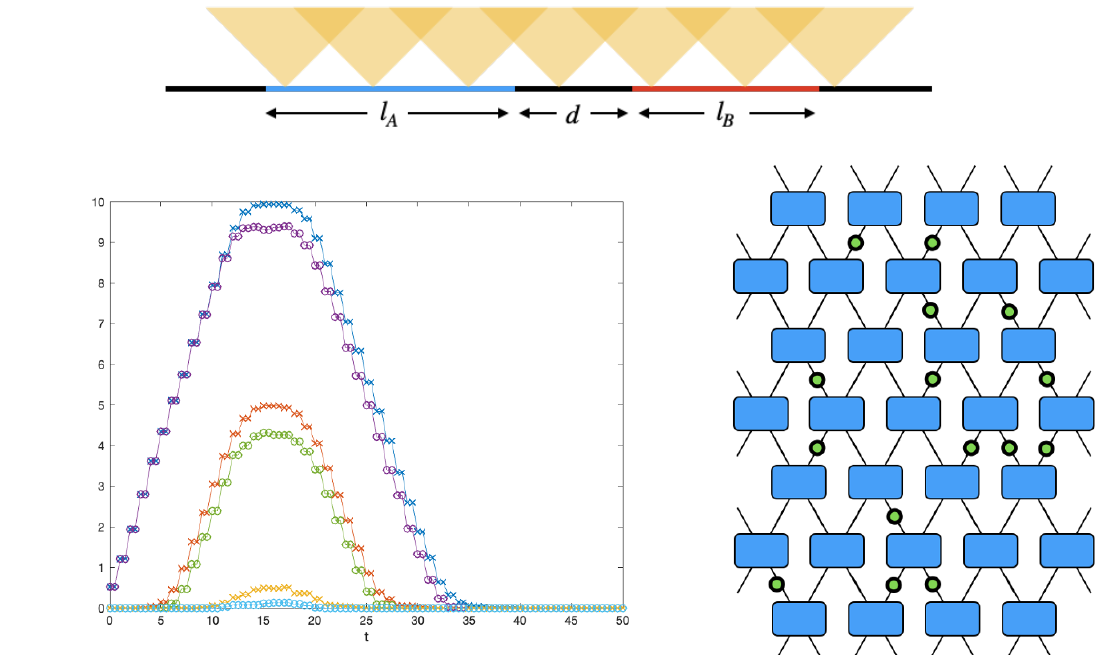
Figure 16 . The mutual information ( (cid:2) ’s) and EPR pairs ( (cid:14) ’s) between region A (blue) and B (red) after a global quantum quench. We start in the product state of all spin up and take l A = 30, l B = 20, d = f 0 ; 10 ; 20 g . On the right, we show a cartoon of the random Cli(cid:11)ord circuit where CNOT gates (blue rectangles) are applied in a regular brick-layered fashion while phase and Hadamard gates (green circles) are applied randomly. We average over 100 disorder